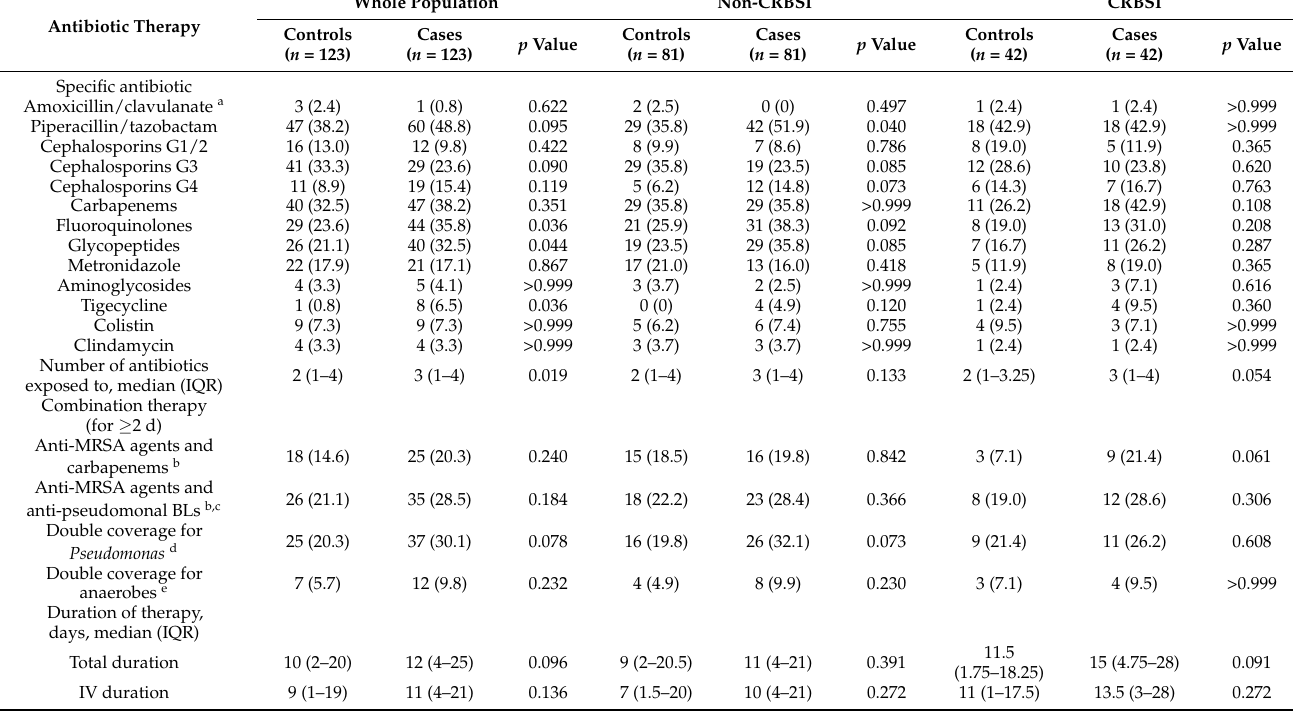
Table 2. Antibiotic therapy in patients with candidemia and matched